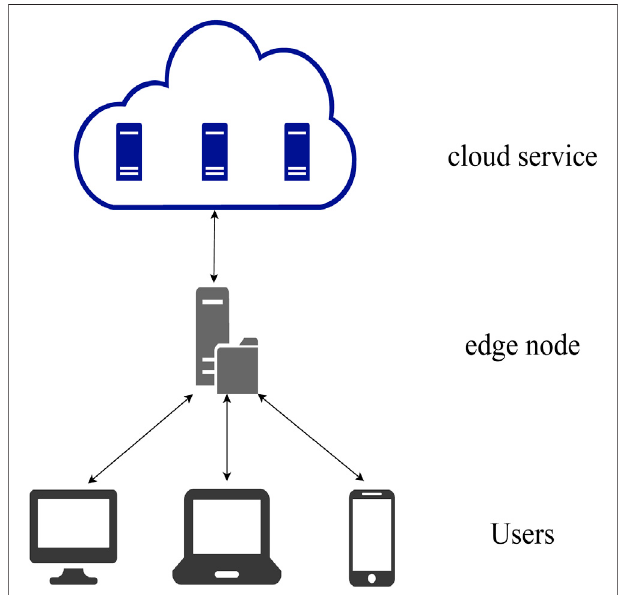
FIGURE 1 | Collaborative cloud-edge computing